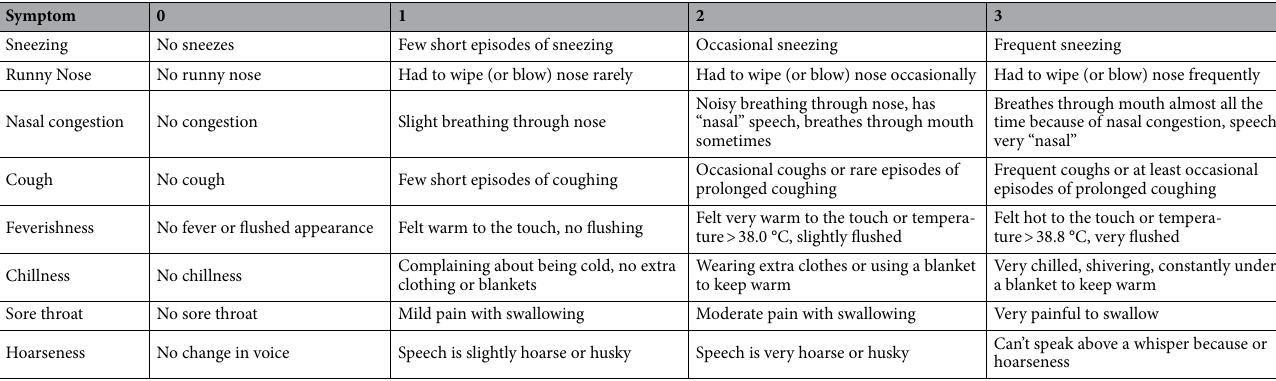
Table 1. Questionnaire filled by the caregivers rating the presence and severity of upper respiratory infection (URI) symptoms in children 12 . The Questionnaire was obtained and modified from Taylor et al. Pediatr. Res . 2010